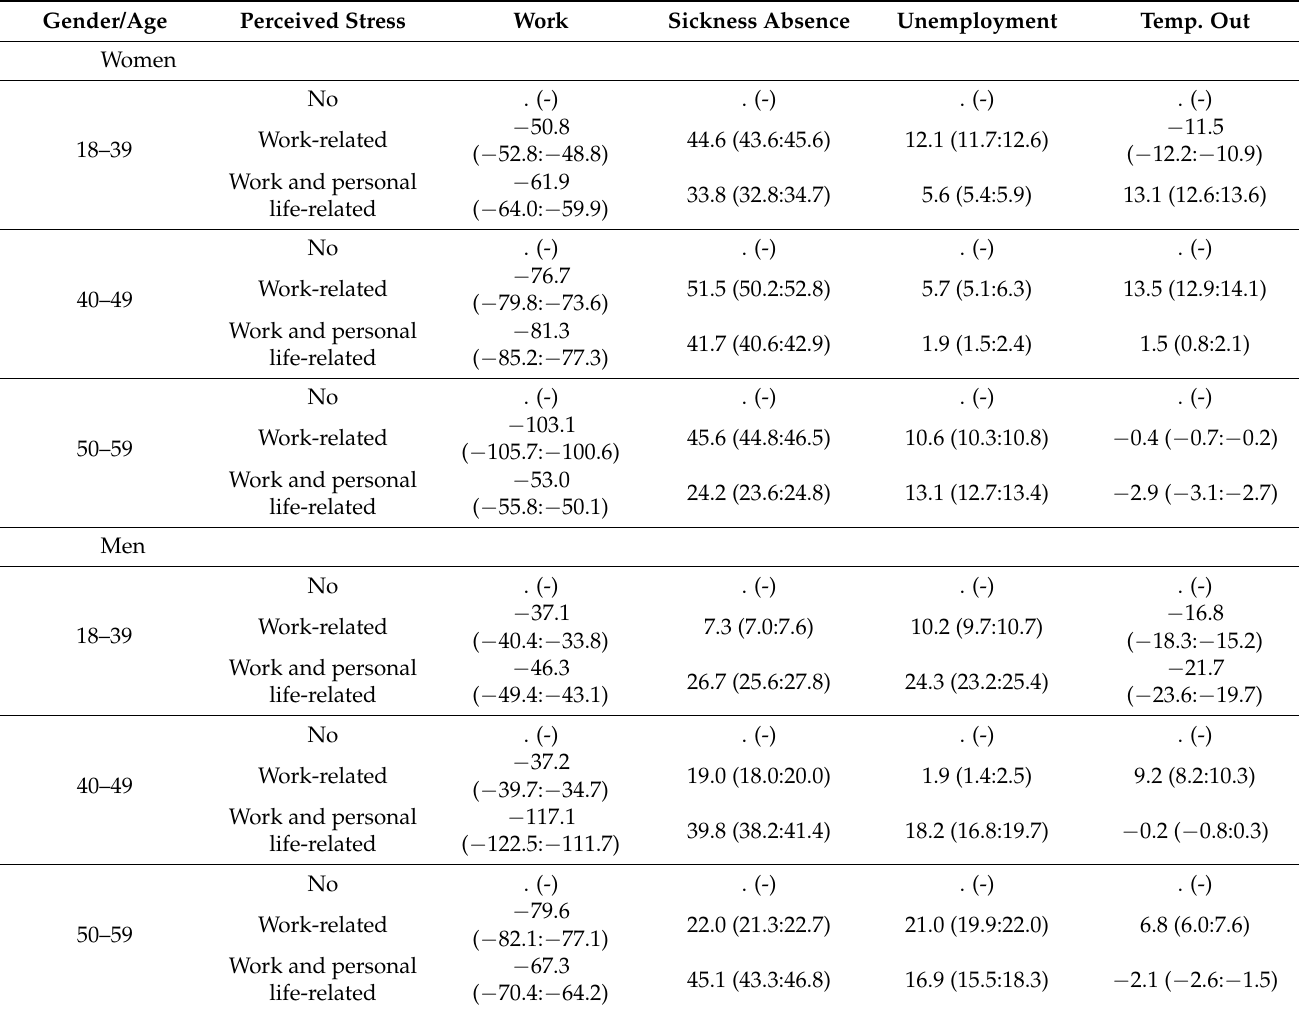
Table 2. Expected average number of days (95% confidence interval) spent in the four recurrent labor market affiliation states (ELMA estimates) for perceived stress, stratified by gender and age group. Gender/Age Perceived Stress Work Sickness Absence Unemployment Temp.